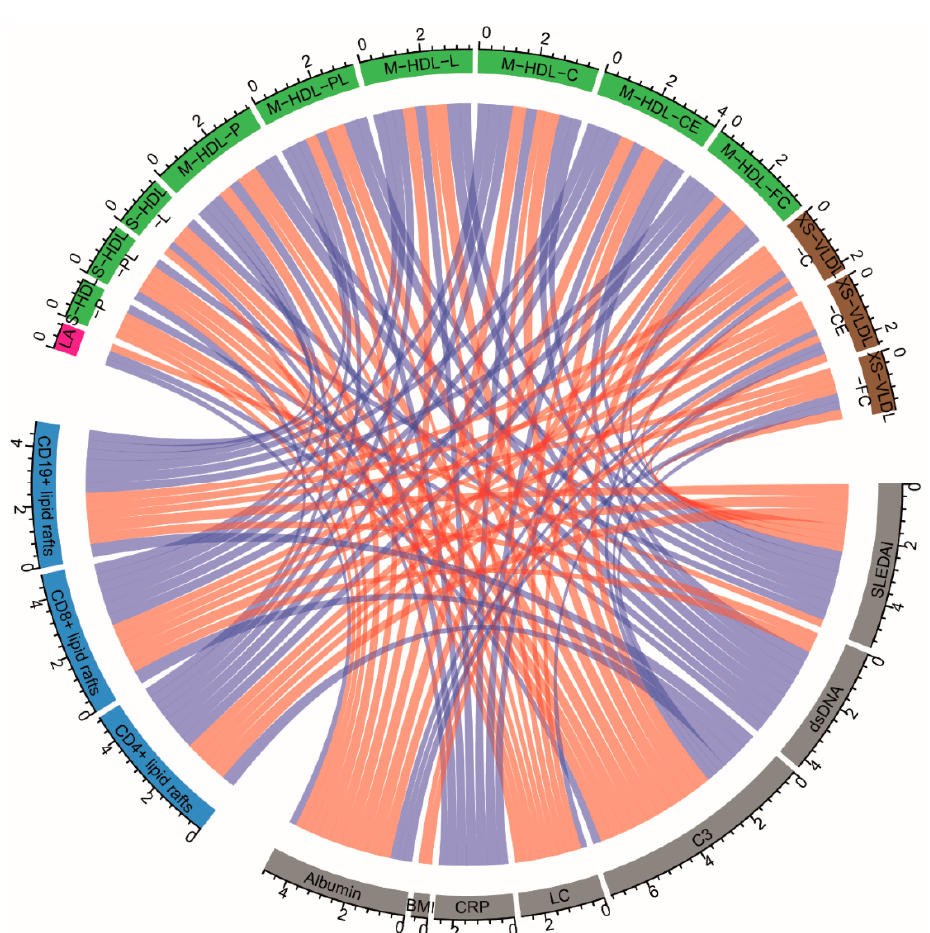
Figure 5. Association between selected serum lipid metabolites, clinical measure of disease activity and lipid rafts in JSLE. Correlations between selected lipid metabolites, clinical factors, and lipid raft. Pearson correlation coefficients are represented as edges connecting the lipid metabolites section (green/pink/brown), clinical factor (grey) section and lipid raft section (blue). The width of the edges represents the size of the correlation. Only statistically significant correlations following adjustment for multiple comparisons (10% FDR) are shown. Red lines represent positive correlation and blue lines represent negative correlation. Abbreviations: VLDL, very low-density lipoprotein; HDL, high density lipoprotein; XS, very small; S, small; M, medium; C, cholesterol; CE, cholesterol ester; FC, free cholesterol; L, total lipids; P, particles; PL, phospholipids; LA, linoleic acid; BMI, Body Mass Index; SLEDAI, Systemic Lupus Erythematosus Disease Activity Index; dsDNA, anti-double-stranded-DNA antibodies; C3, complement component 3; LC, lymphocyte